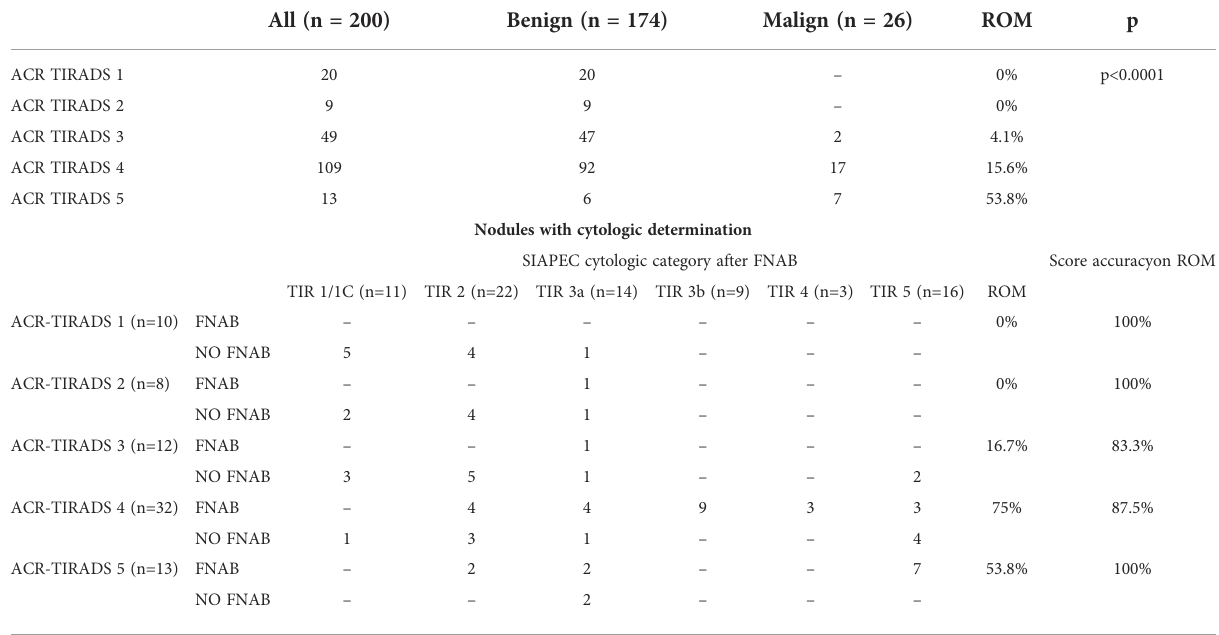
TABLE 4 Correlation between cytological categories and ACR-TIRADS score. All